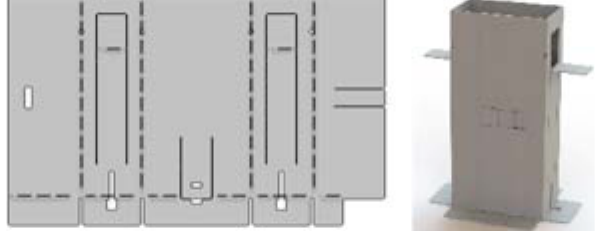
Figure 6. 2-D stamping folded into sheath shell.